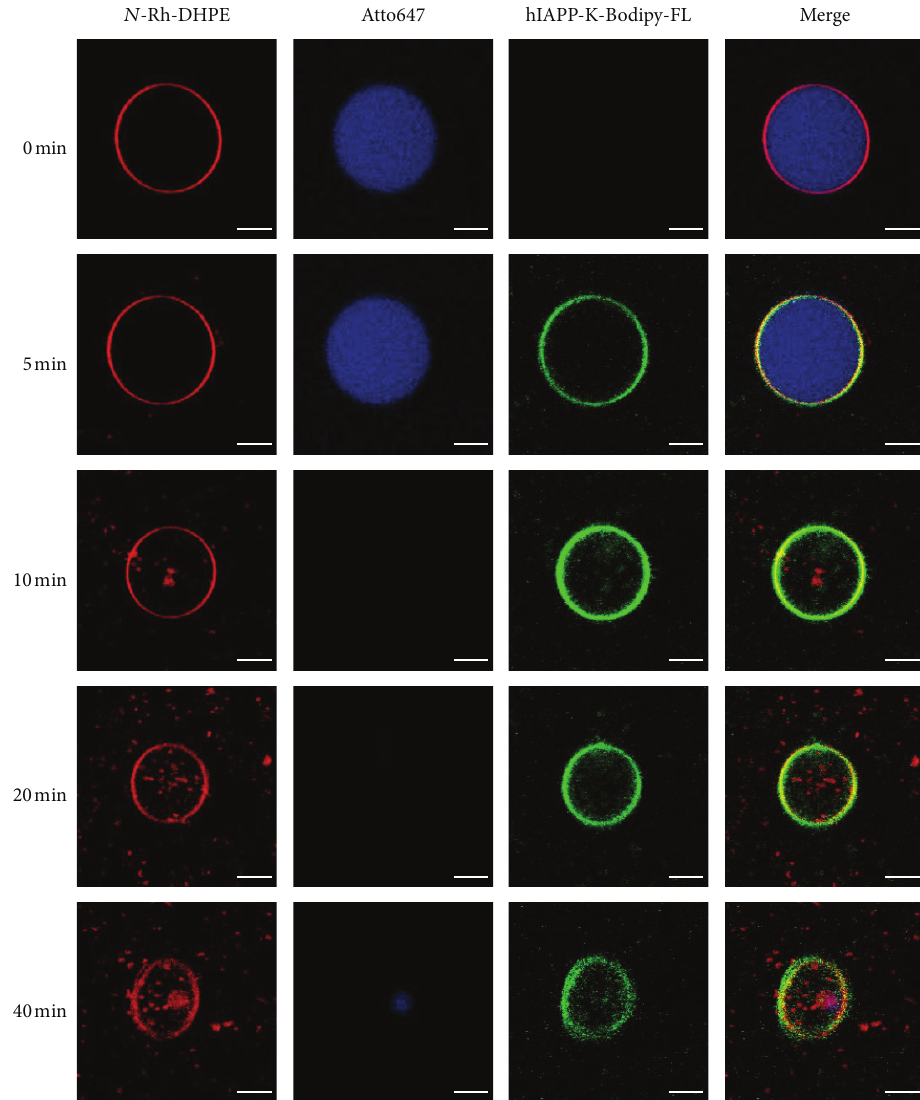
Figure 6: Visual leakage assay studying the interaction of hIAPP with biological membrane and its consequence. Confocal fluorescence microscopy images of the interaction of 5 𝜇 M hIAPP with giant unilamellar vesicles (GUVs) composed of lipids extracted from a pancreatic 𝛽 -cell line of rat (INS-1E). The GUVs which are labelled with N -Rh-DHPE (red) are filled with phosphate buffer containing the fluorophore Atto647 (blue). C-terminally labelled hIAPP-K-Bodipy-FL (green) adsorbs within the first 5 min to the lipid vesicles and leads to membrane permeabilization and disintegration of the GUV. The scale bars represent 10 𝜇 m. Reprinted from [60] with permission from